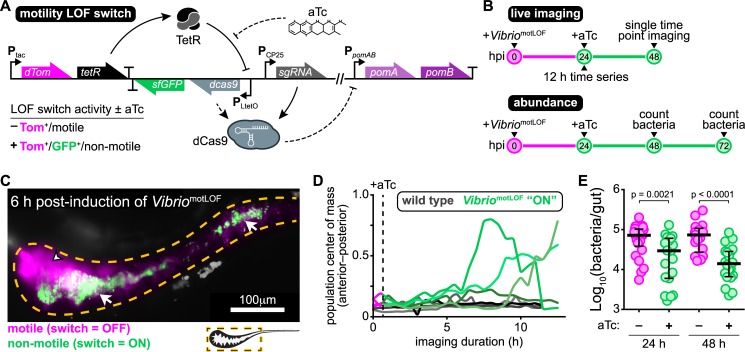
Sustained swimming motility is required for maintaining intestinal spatial organization and persistence.(A) Schematic of CRISPRi-based motility LOF switch. Lower left table summarizes switch activity and bacterial behaviors +/− aTc. Bent arrows denote promoters; “T” denotes transcriptional terminators. Solid lines represent constitutive interactions; dashed lines represent induced interactions. (B) Experimental timelines used to investigate in situ inactivation of swimming motility. (C) A maximum intensity projection acquired by LSFM of an animal colonized by VibriomotLOF at 6 hpi. Dashed line marks approximate intestinal boundaries. An arrowhead with a black stroke marks an area of swimming cells expressing only dTomato (magenta, “switch = OFF”). White tailed arrowheads mark aggregated cells (green, “switch = ON”). (D) Population center of mass over time for intestinal populations of wild-type Vibrio (gray) and VibriomotLOF (magenta/green). Lines are single bacterial populations within individual fish. Vertical dashed line marks time of aTc induction. (E) Abundances of VibriomotLOF at 24 and 48 hpi with aTc. Bars denote medians and interquartile ranges. Significant differences determined by Mann-Whitney. Underlying data plotted in panels D and E are provided in S1 Data. aTc, anhydrotetracycline; CRISPRi, CRISPR interference; hpi, hours post induction; LOF, loss-of-function; LSFM, light sheet fluorescence microscopy.